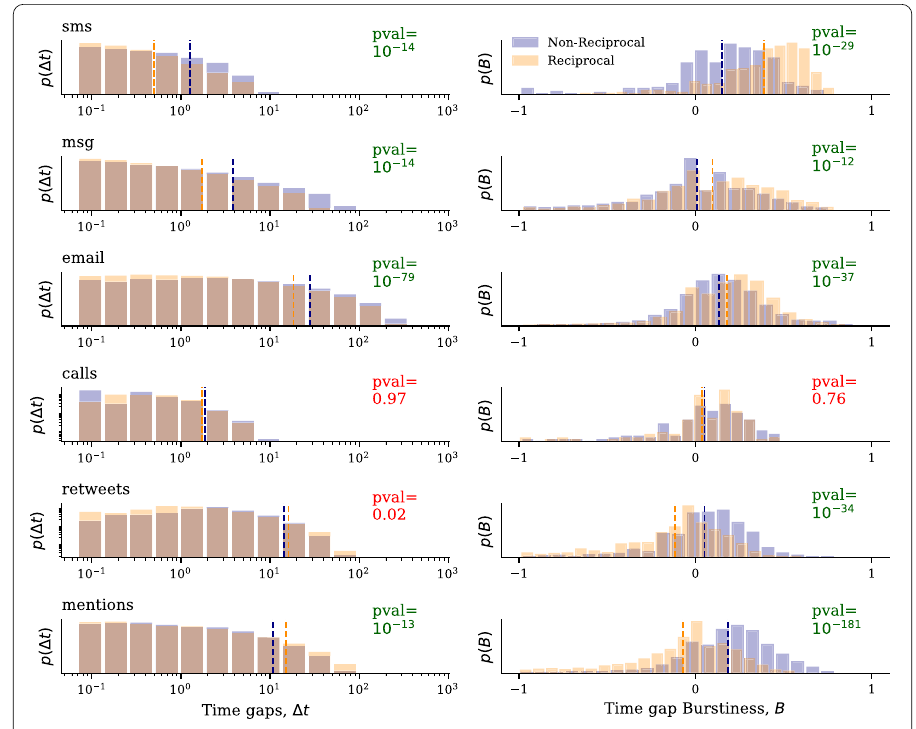
Figure 3 Reciprocation is more bursty than non-reciprocation in human communication, and varies across channels. Distribution p ( (cid:2) t ) of the time gap (cid:2) t (in days) within (non-)reciprocations (left column), and distribution p ( B ) of the time gap burstiness B (right column), both over links of all communication channels. Mean values (cid:4) (cid:2) t (cid:5) and (cid:4) B (cid:5) are marked by dashed lines (same colors as corresponding histograms). Reciprocations seem to be faster, showing smaller time gaps than non-reciprocations, for conversation channels (calls, sms, msg, emails), while the opposite holds for Twitter. Reciprocal communication is significantly more bursty (non-homogeneous) than non-reciprocity for sms, msg and email, and becomes less so for calls and the broadcasting channels retweets and mentions. We compute statistical significance of the difference between two distributions via a Kolmogorov-Smirnov (KS) 2-sample test; p -values (pval) < 0.01 are deemed significant (green, otherwise